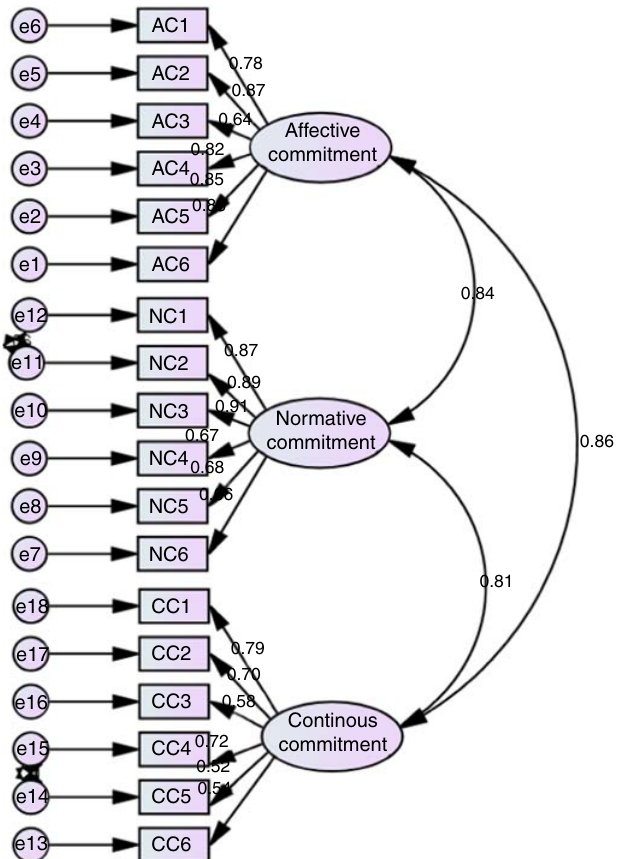
Figure 3. Confirmatory factor analysis (CFA) of measures for organizational commitment